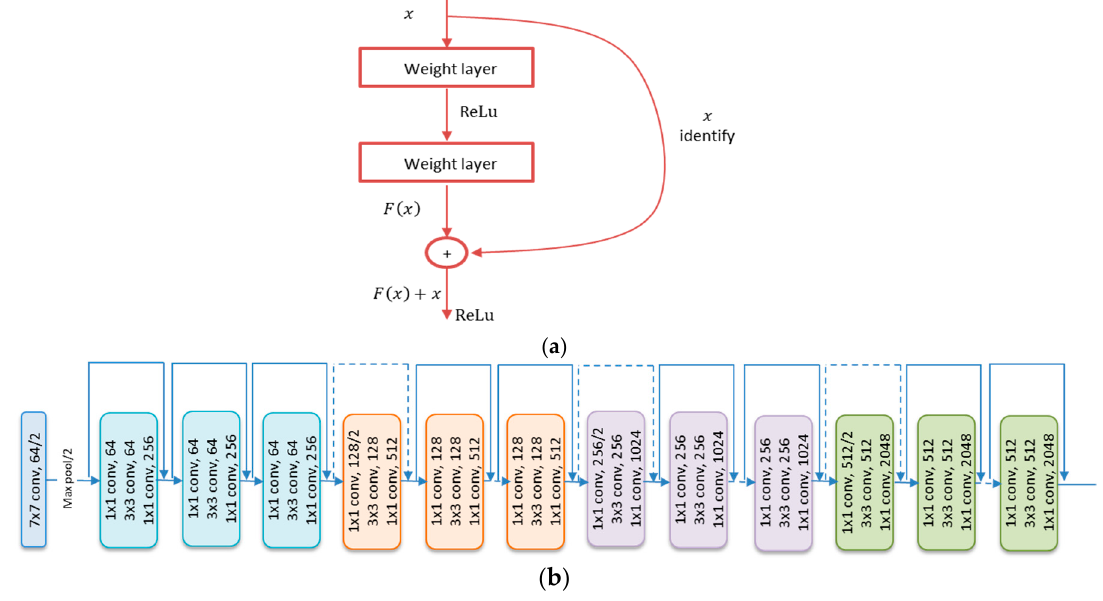
Figure 2. ( a ) Residual block; and ( b ) architecture of ResNet50.